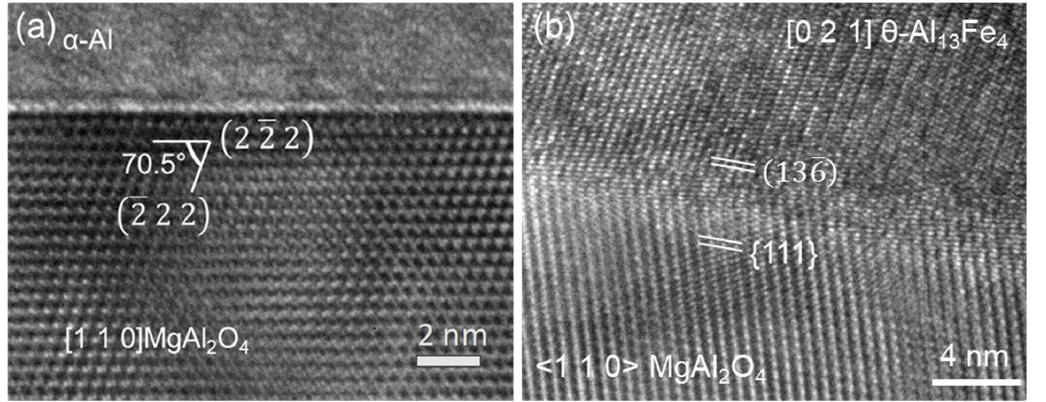
Figure 16. Heterogeneous nucleation of θ‐ Al 13 Fe 4 on a native MgAl 2 O 4 particle. ( a ) HRTEM image of MgAl 2 O 4 with the electron beam paralleled to <1 1 0> zone axis showing {1 1 1} faceting on the MgAl 2 O 4 particle, ( b ) HRTEM image showing the MgAl 2 O 4 / θ‐ Al 13 Fe 4 interface with electron beam parallel to [110] of MgAl 2 O 4 and [021] of θ‐ Al 13 Fe 4 , revealing an orientation relationship (OR) be ‐ tween the oxide and θ‐ Al 13 Fe 4 : (cid:3435) 2 2 2 (cid:3439) MgAl 2 O 4 // (cid:3435) 1 3 6 (cid:3439) θ‐ Al 13 Fe 4 and [1 1 0] MgAl 2 O 4 //3.4° [0 2 1] θ‐ Al 13 Fe 4 . [67]. θ -Al 13 Fe 4 .